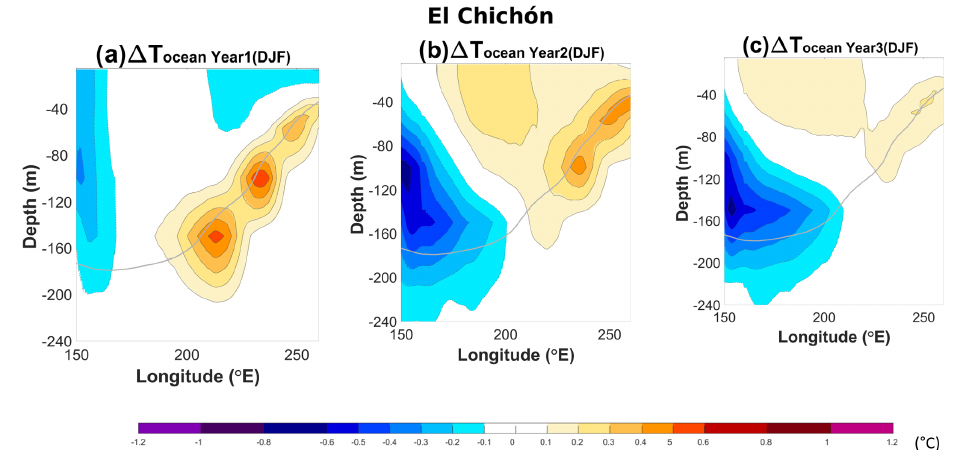
Figure A15. Ensemble mean changes shown for a transect in the equatorial Pacific (averaged 5 ◦ N–5 ◦ S) of the ocean temperature (shadings) between the volcano case and the climatology for each of the following three winter seasons (DJF) after the Chichón eruption. Contours show the SST anomalies following the colour bar scale (solid lines for positive anomalies and dashed lines for negative anomalies; the 0 line is omitted). The bold grey line shows the climatological thermocline depth (as defined using the 20 ◦ C isotherm). This is shown for 100 ensemble members.